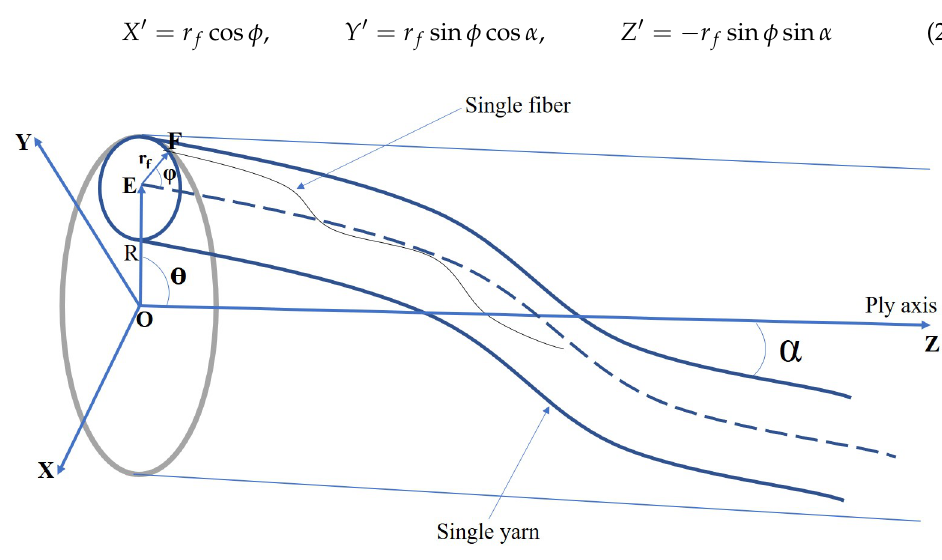
Figure 8. Arrangement of yarns on the plied